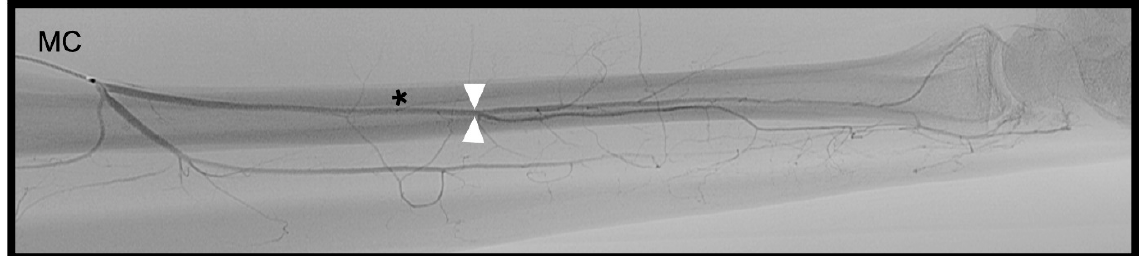
Figure 4. Palmo-dorsal superselective angiography of the * AIA. maximum diameter proximally to its main branches, MC inside the common interosseous artery (AIA = anterior interosseous artery; MC = microcatheter).